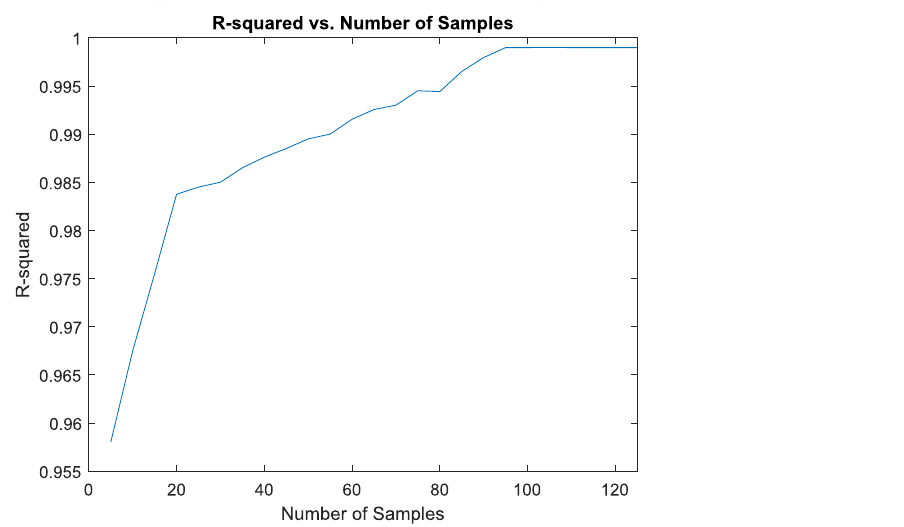
Figure 5. Complete architecture of the proposed method. For the full architecture of the DCNN, refer to Fig. 4.